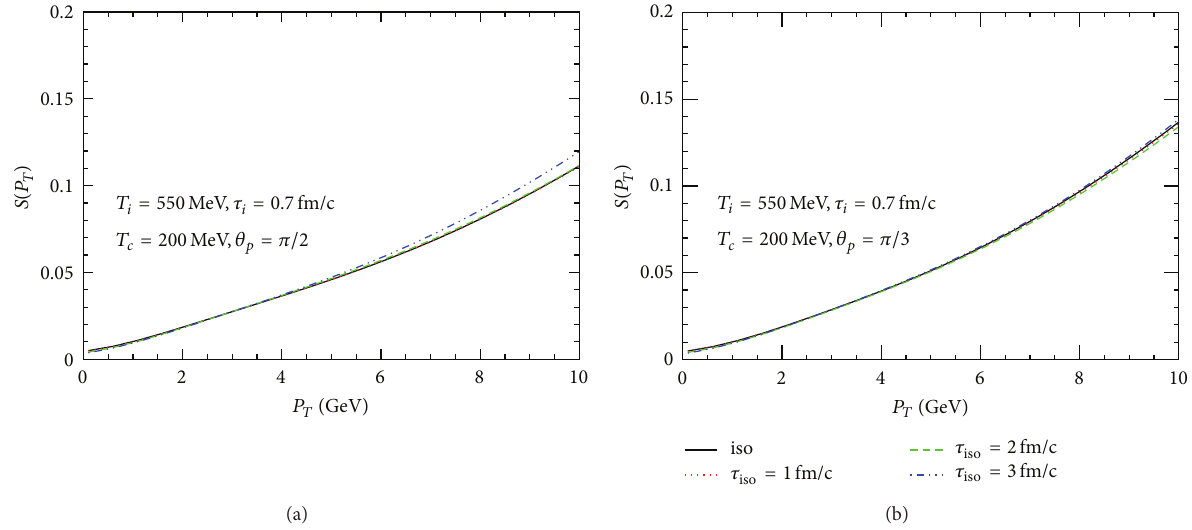
Figure 5: (Color online) The survival probability of 𝐽/𝜓 in an anisotropic plasma at central and forward rapidity region. The initial conditions are taken as 𝑇 𝑖 = 550 MeV, 𝑇 𝑐 = 200 MeV, and 𝜏 𝑖 = 0.7